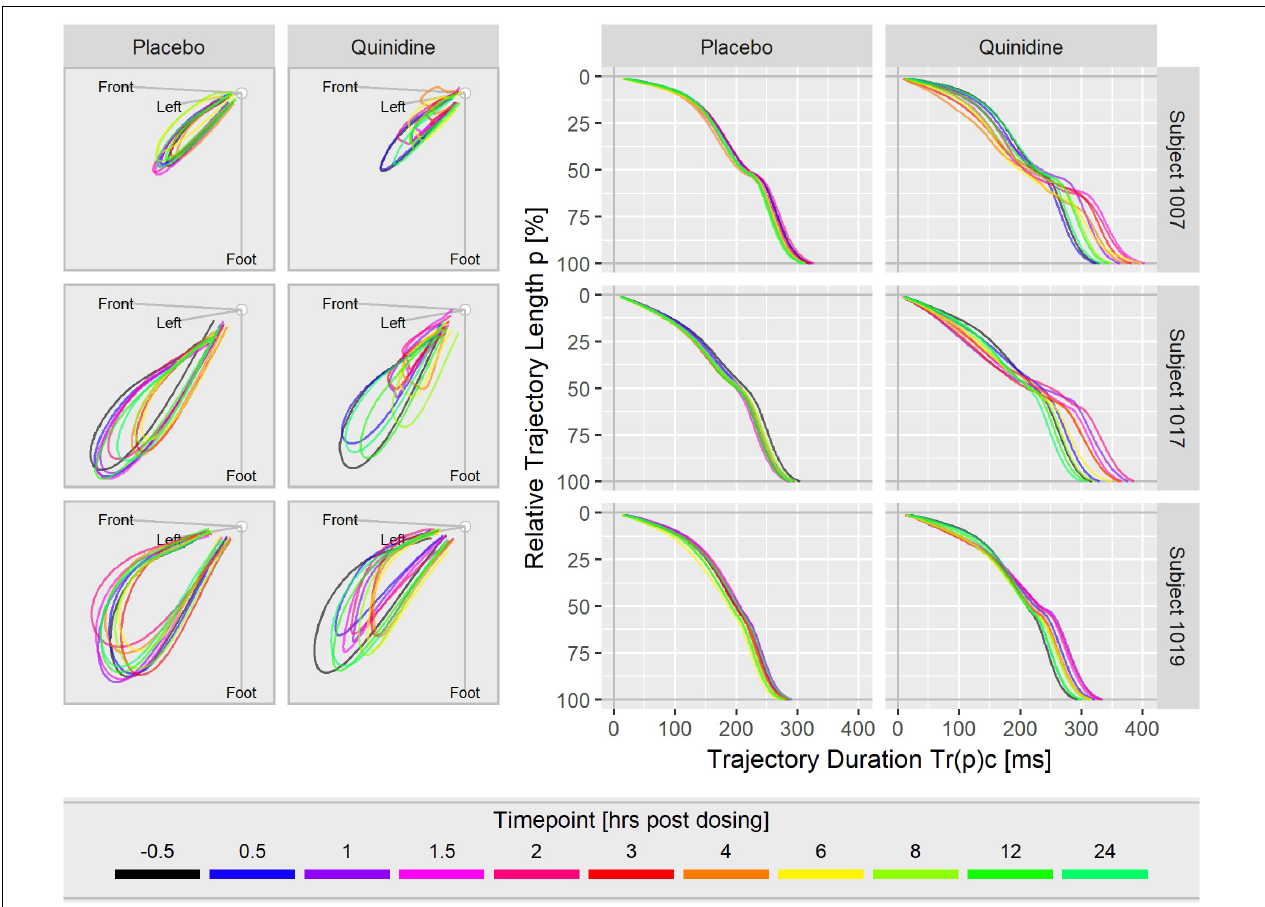
FIGURE 3 | T vector trajectories (left) and heart rate corrected trajectory duration curves (right) from three subjects under placebo and under quinidine treatment during a day. The colored timepoints denote the time in hours post-dosing. Quinidine maximum concentrations were 2130 ng/mL for subject 1007, 1100 ng/mL for subject 1017, 1680 ng/mL for subject 1019.